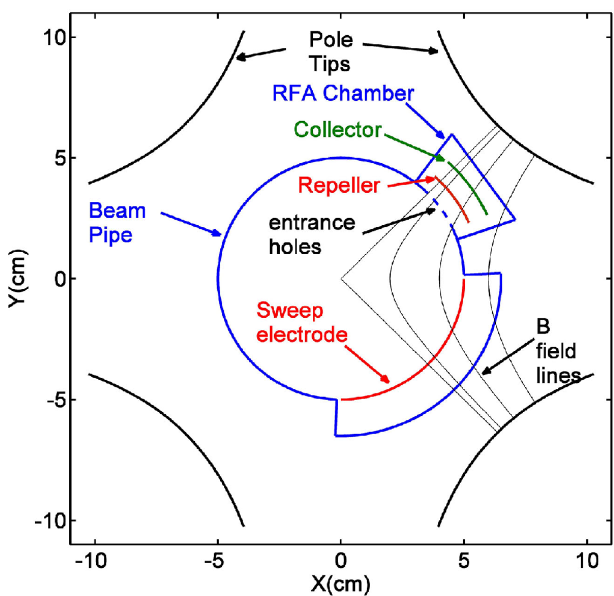
FIG. 4. (Color) View of the RFA chamber with flange cover removed. Visible components include the stainless steel RFA entrance plate (2.8 mm holes) which is covered with a copper plate with slightly larger holes, the repeller screen mounted on rf capacitors beneath the screen, and ceramic standoffs to which the collector plate will be